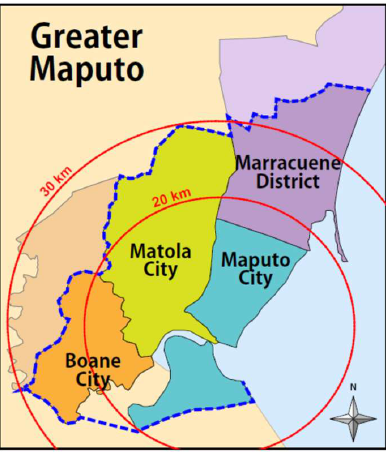
Figure 1. Map of the Greater Maputo metropolitan area, which shows the four main cities/district it covers, as taken from the report of the Japan International Cooperation Agency (JICA) [25].